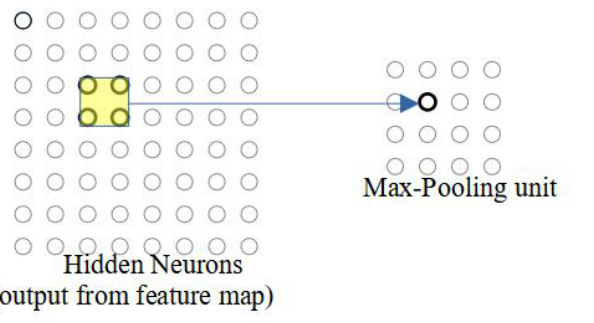
Figure 4. Max pooling of 2 × 2 on the output feature